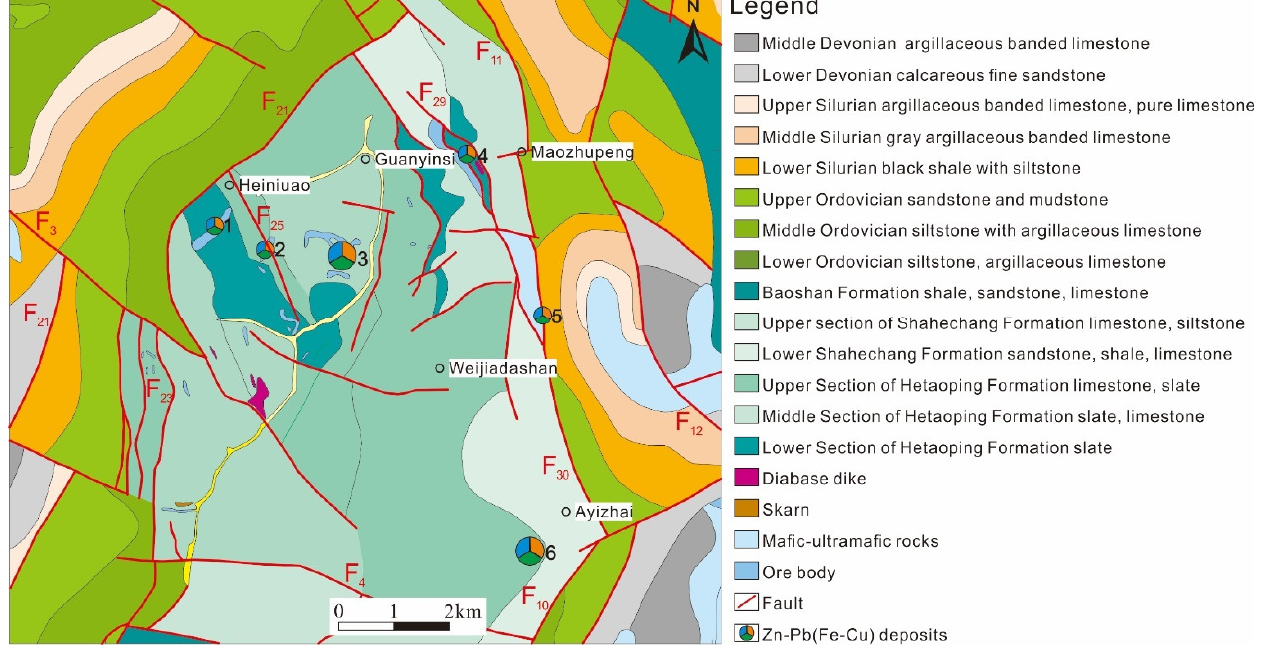
Figure 2. Geological map of the Hetaoping Pb-Zn deposit in Baoshan, Yunnan (modified after [37]).